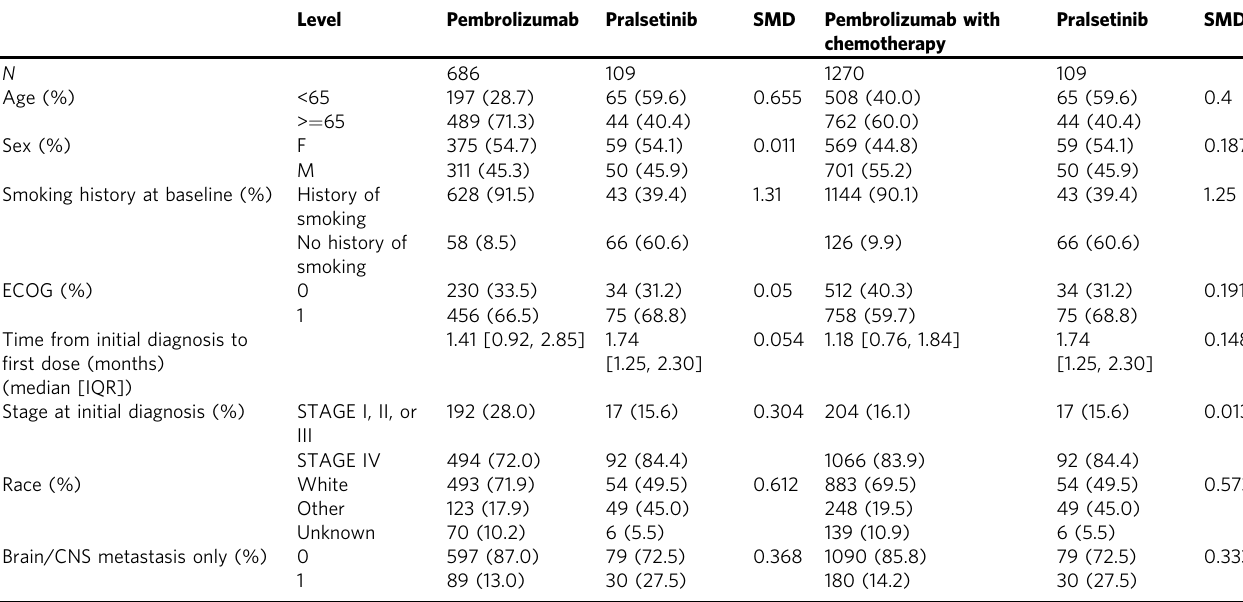
Table 2 Baseline characteristics of the 1 L ARROW trial participants given pralsetinib and Flatiron EDM cohort given 1 L pembrolizumab, and 1 L pembrolizumab with chemotherapy without adjustment; balanced variables are those with SMD < 0.1.